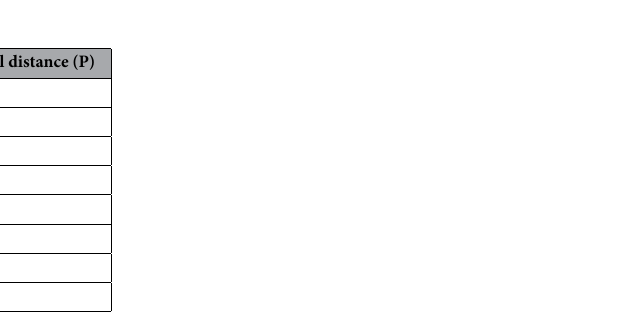
Table 4. The number of groups inferred from ABGD analysis according to prior intraspecific divergence ( P